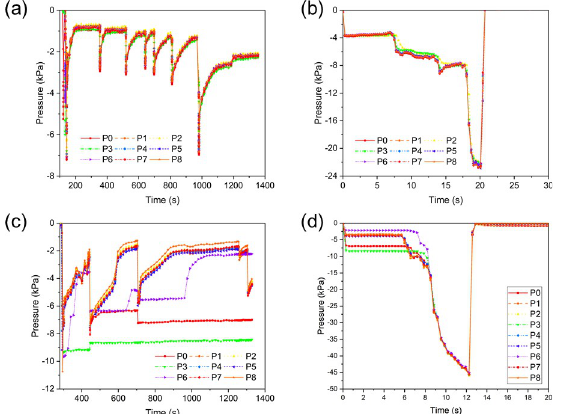
Fig 11. Suction dynamics of two adult sea lampreys in Experiment 2. (a) Suction pressure when an adult female lamprey was attaching by itself on the panel, (b) suction pressure when the lamprey in (a) was pulled away from the panel, (c) suction pressure when another adult female lamprey was attaching by itself on the panel, and (d) suction pressure when the lamprey in (c) was pulled away from the